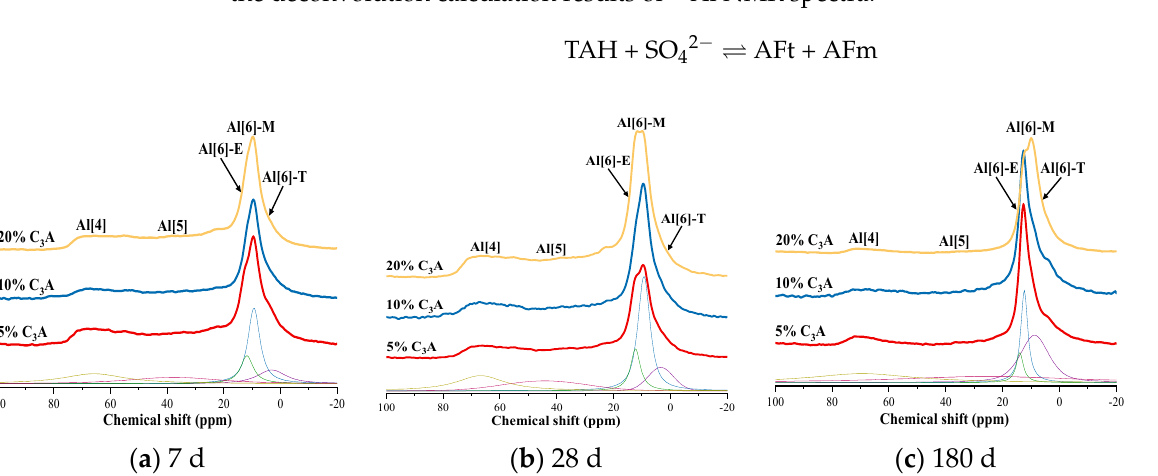
Figure 6. 27 Al NMR spectra of C 3 S-C 3 A paste under sulfate attack.